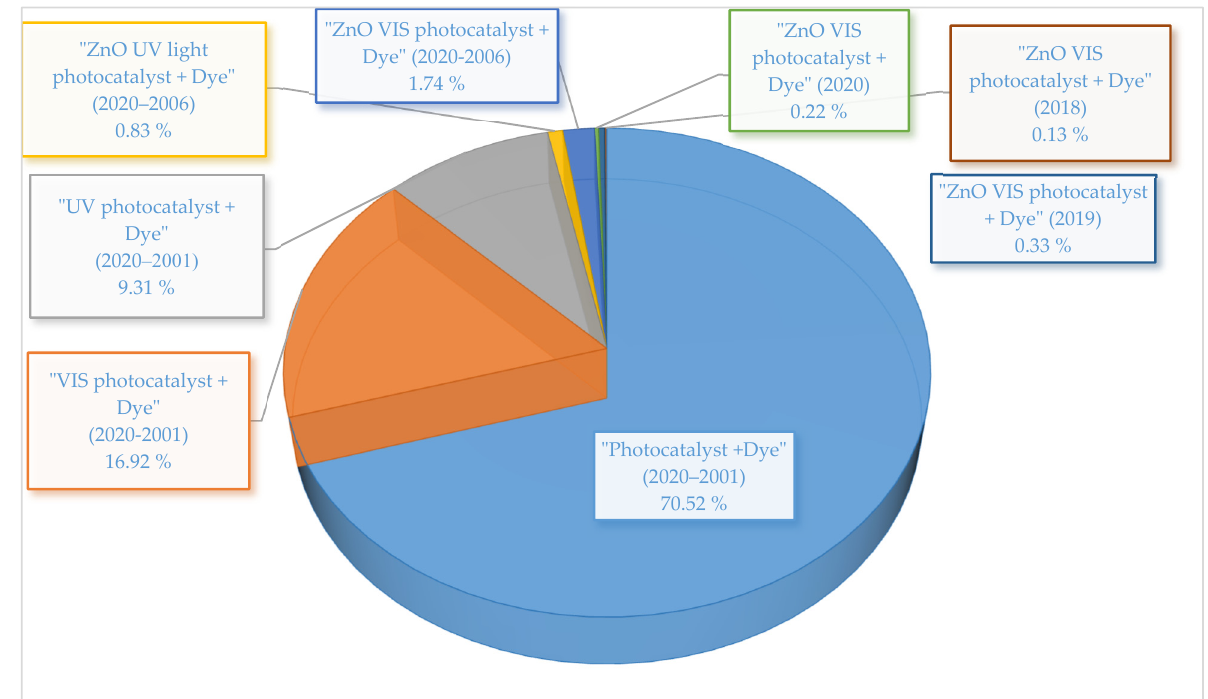
Figure 1. SciFinder Scholar ® results with several “photocatalyst + dye” search keywords.